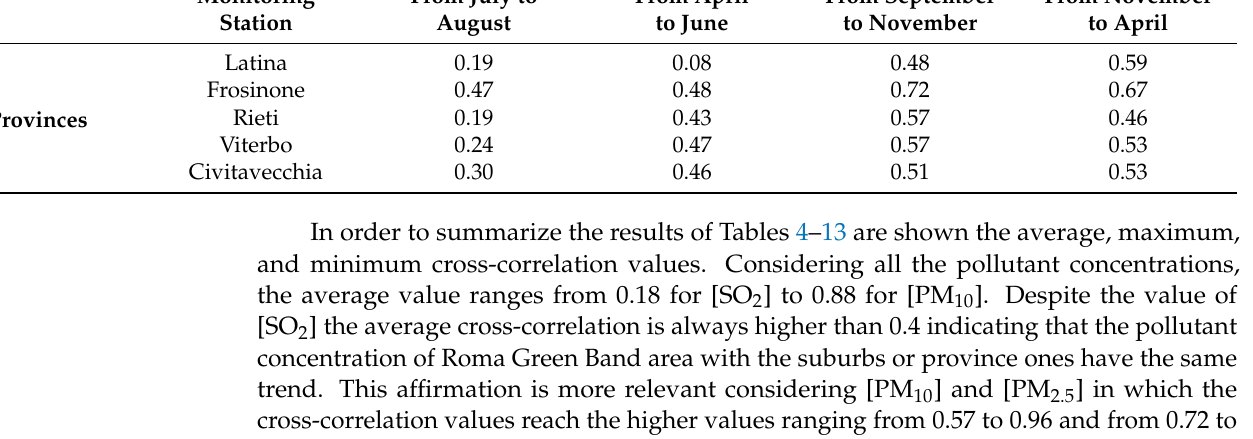
Table 5. Cross-correlation values between Roma Green Band and suburbs or province stations of [CO] in 2015.